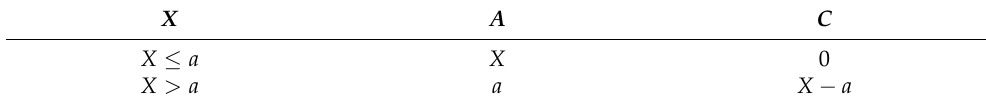
Table 1. Absolute deductible with parameter a ≥ 0. X A C X ≤ a X 0 X > a a X −